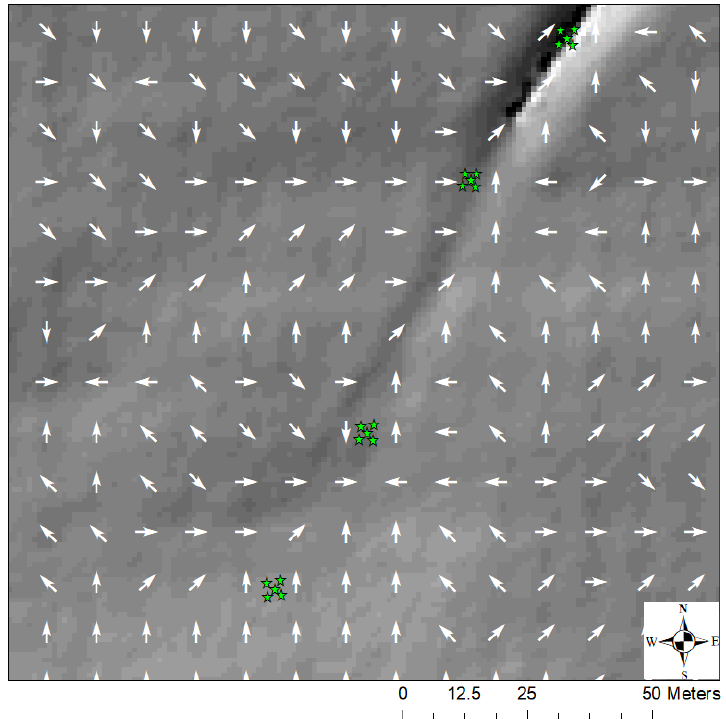
Figure 4. Sampling location selection using geospatial analysis: LIDAR data were used to generate a 1-m resolution digital elevation map for the study site. Elevation data were then analyzed to develop a flow direction map and isolate the dominant flow pathways (white arrow) that were sampled (green star) along the